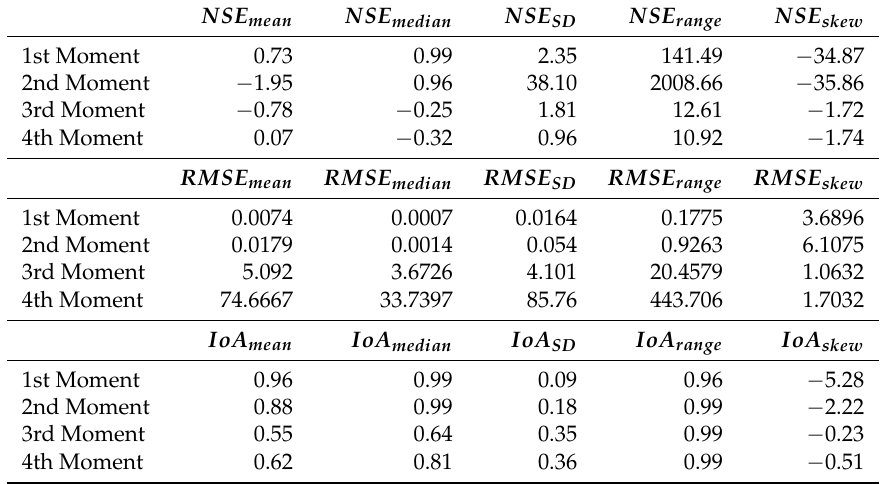
Figure 8. Map of the 2nd statistical moment of maximal water depth. Table 1. Summary statistics of model efficiency performance for all time series of the estimated statistical moments at each grid